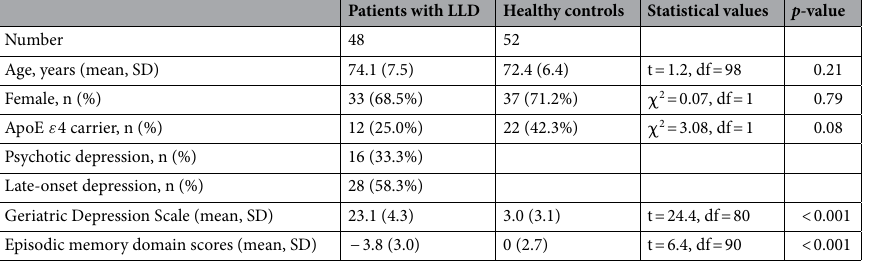
Table 1. Clinical characteristics of participants. SD standard